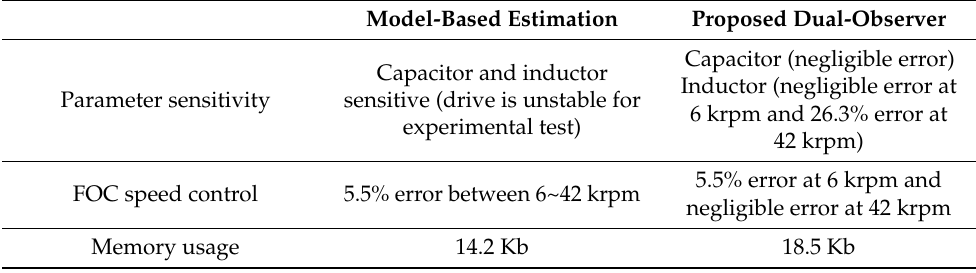
Table 2. Comparison between conventional model-based estimation and proposed dual-observer